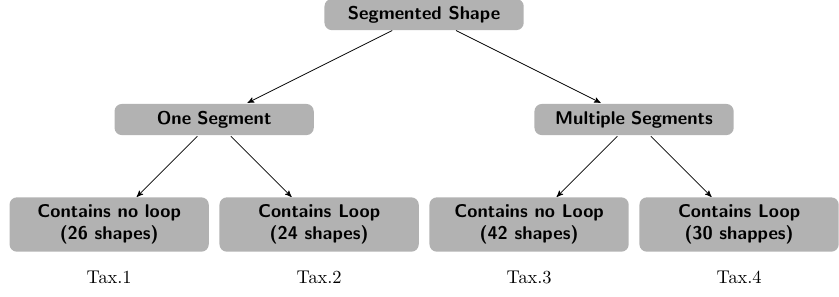
Figure 3. Letters’ taxonomy, according to the number of segments and the existent of